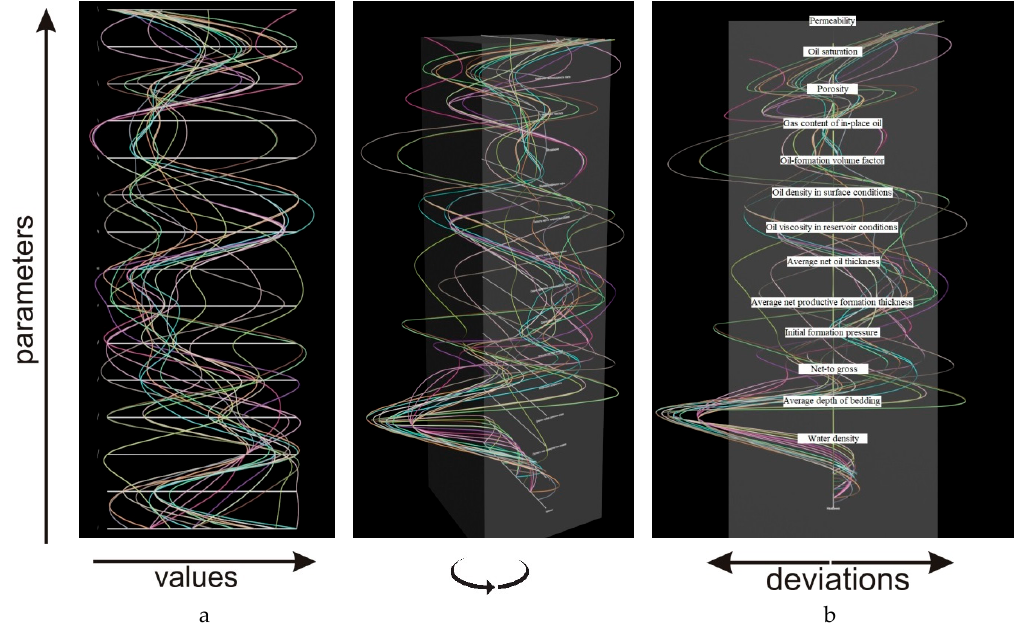
Figure 3. Visual data model for the search of analogies task: ( a ) 2D comparison mode; ( b ) 3D search of analogies mode.